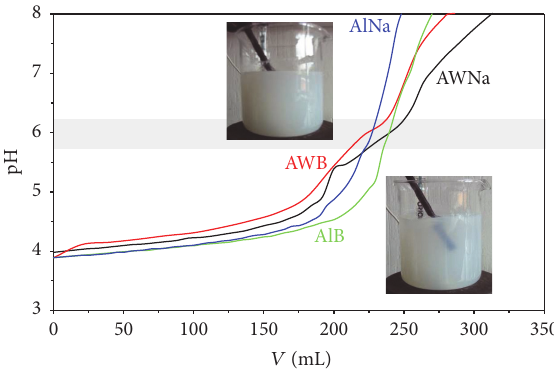
Figure 1: Curves of pH for the formation of boehmite from AlCl 3 ⋅ 6H 2 O (AlNa, with NaOH, and AlB, with n-butylamine) and aluminum waste (AWNa, with NaOH, and AWB, with n- butylamine).